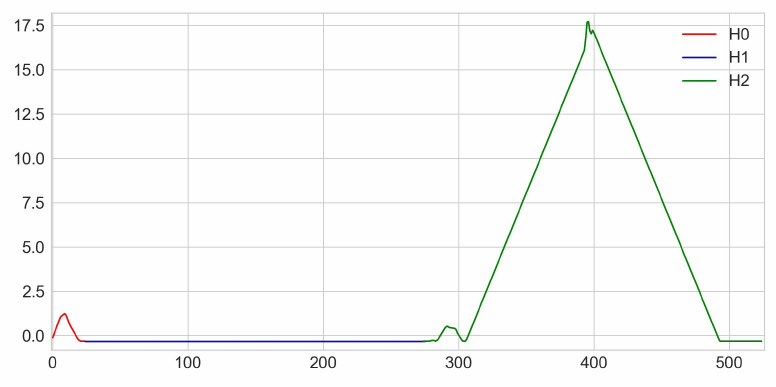
Figure 4. Representation of a vector obtained by persistence